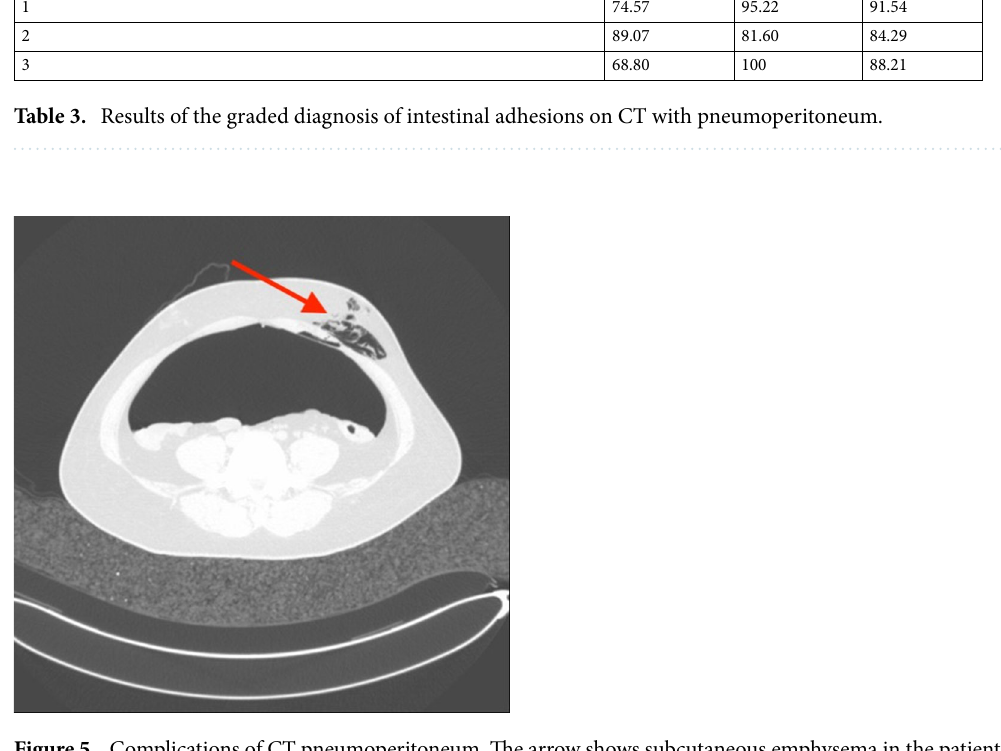
Figure 5. Complications of CT pneumoperitoneum. The arrow shows subcutaneous emphysema in the